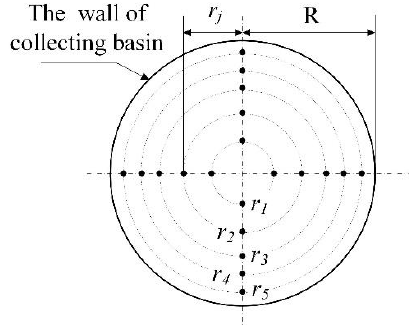
Figure 3. Schematic diagram of NDWCT and the location of monitoring points. Figure 4. Sectional view of collecting basin mearing point.